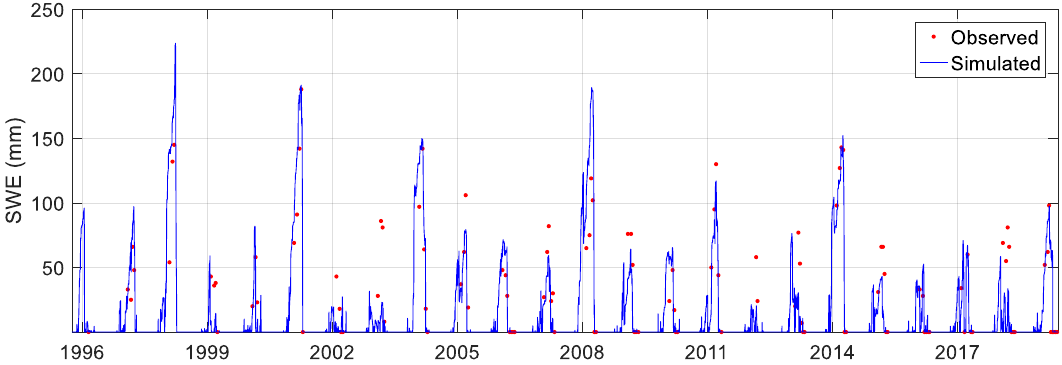
Figure 2. Observed and simulated snow water equivalent (SWE) at the Hemmingford snow survey